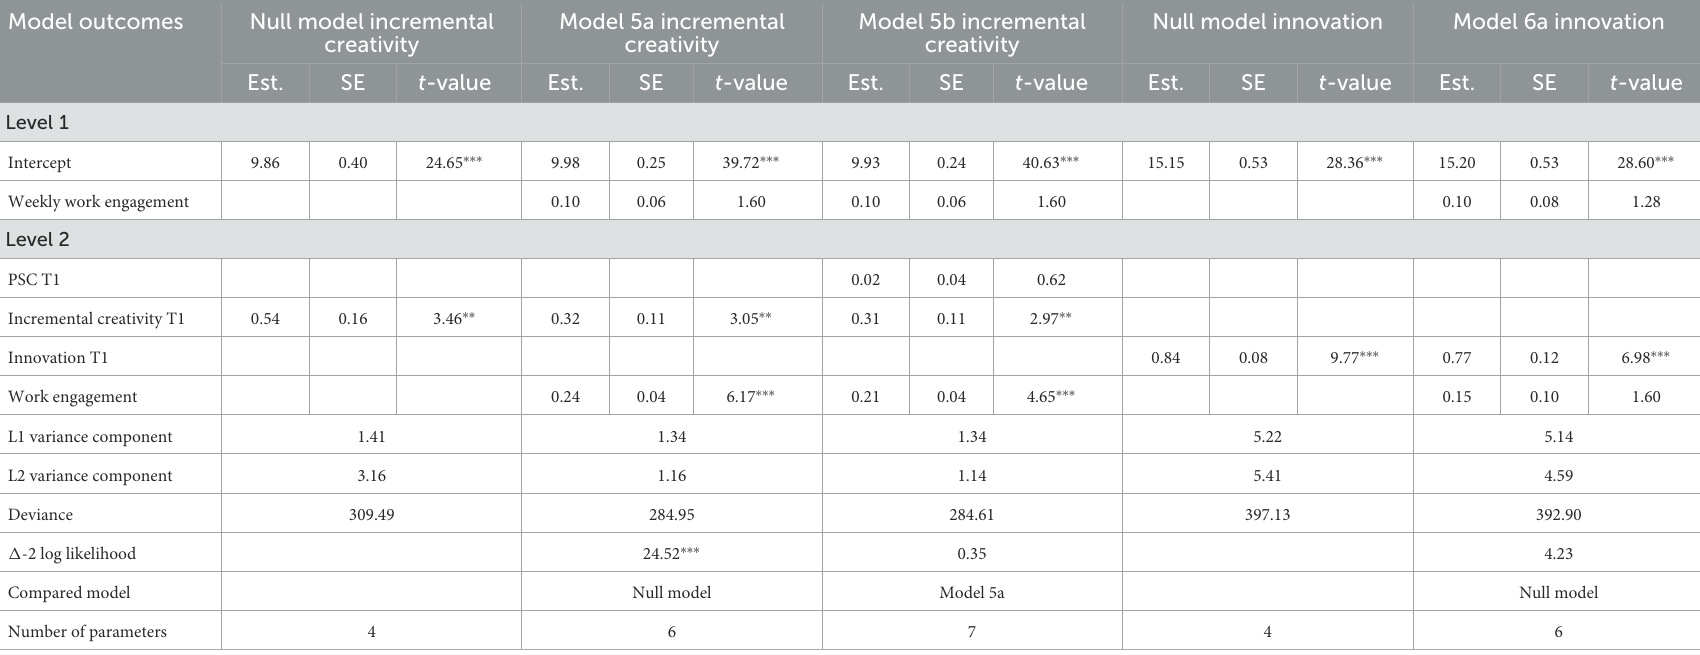
TABLE 5 HLM results of weekly incremental creativity and innovation as